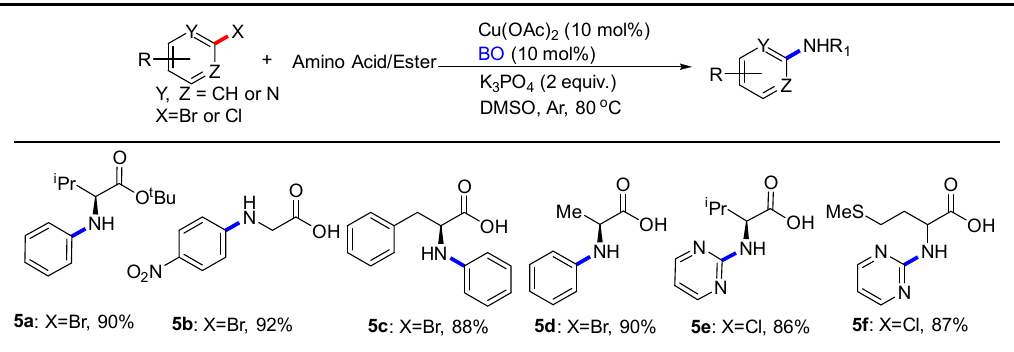
Molecules 2019 , 24 , x 5 of 12